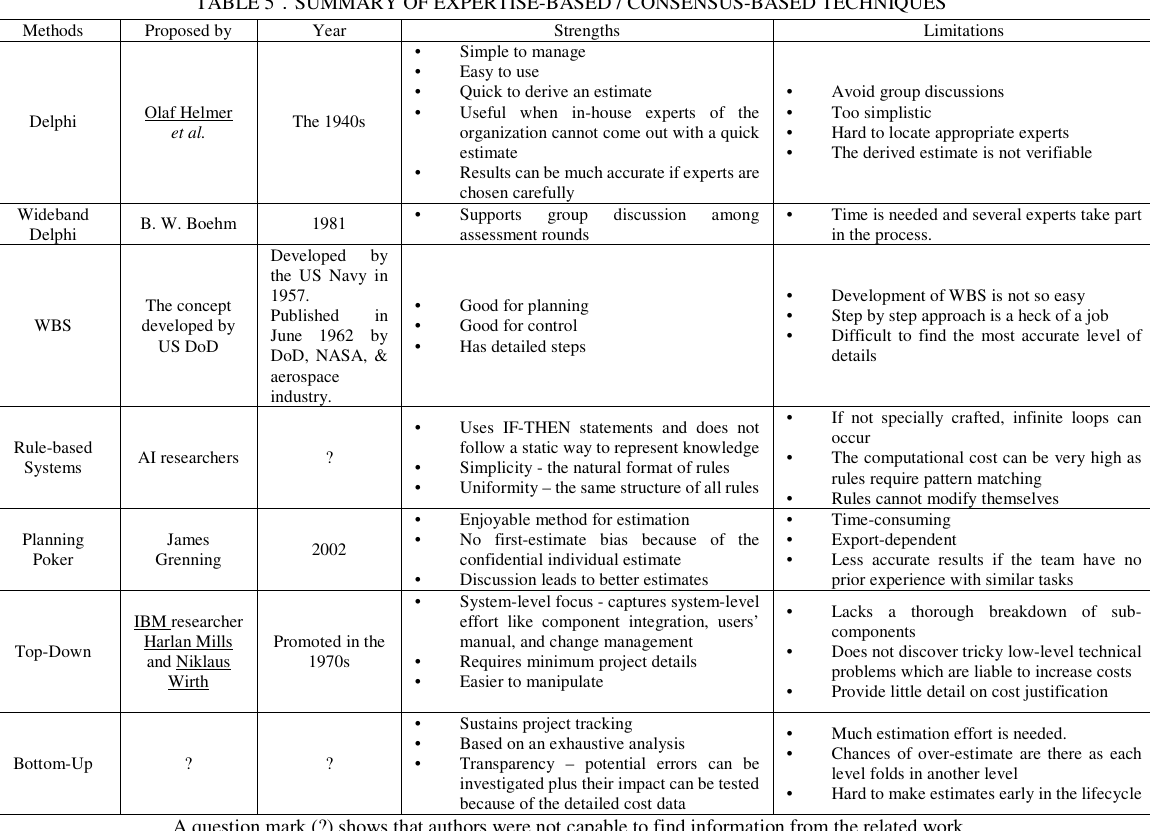
TABLE 5 ． SUMMARY OF EXPERTISE-BASED / CONSENSUS-BASED